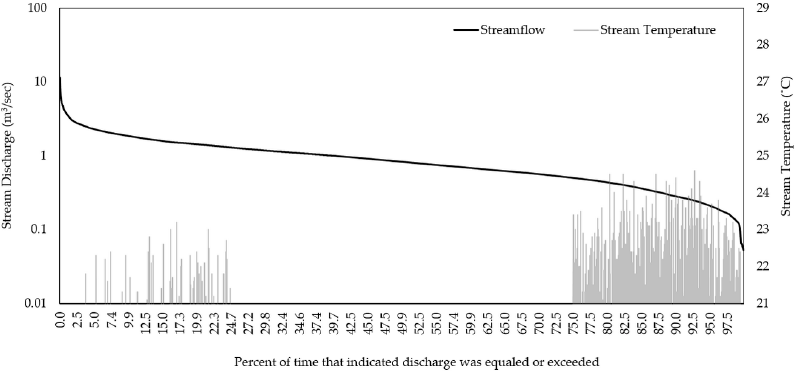
Figure 6. Queen River simulated historical flow duration curve and stream temperatures. The secondary y-axis begins at 21 °C and any temperatures that are not above the stressful threshold are not shown in the figure. The stream temperatures in the Q25–Q75 range are omitted from the figure.